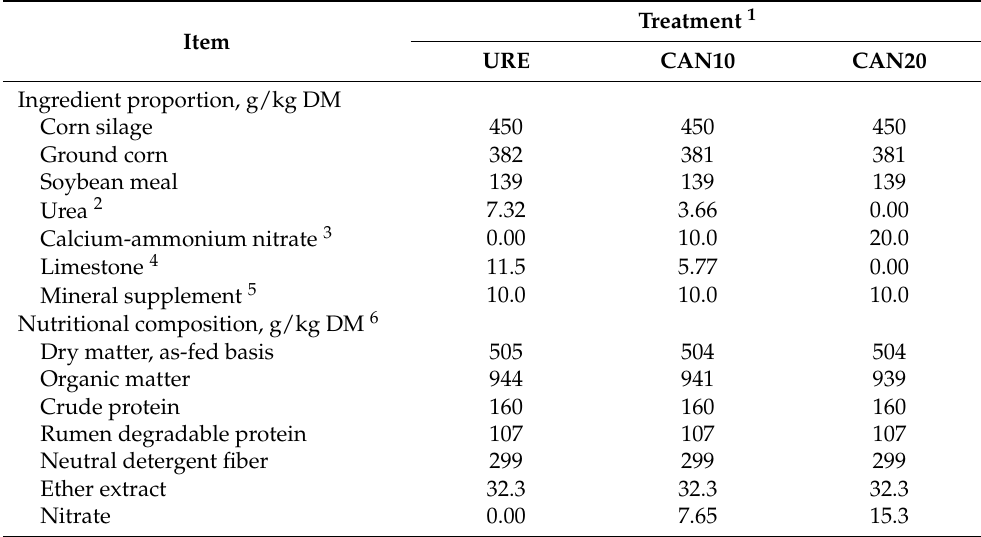
Table 1. Ingredient proportion and nutritional composition of the experimental